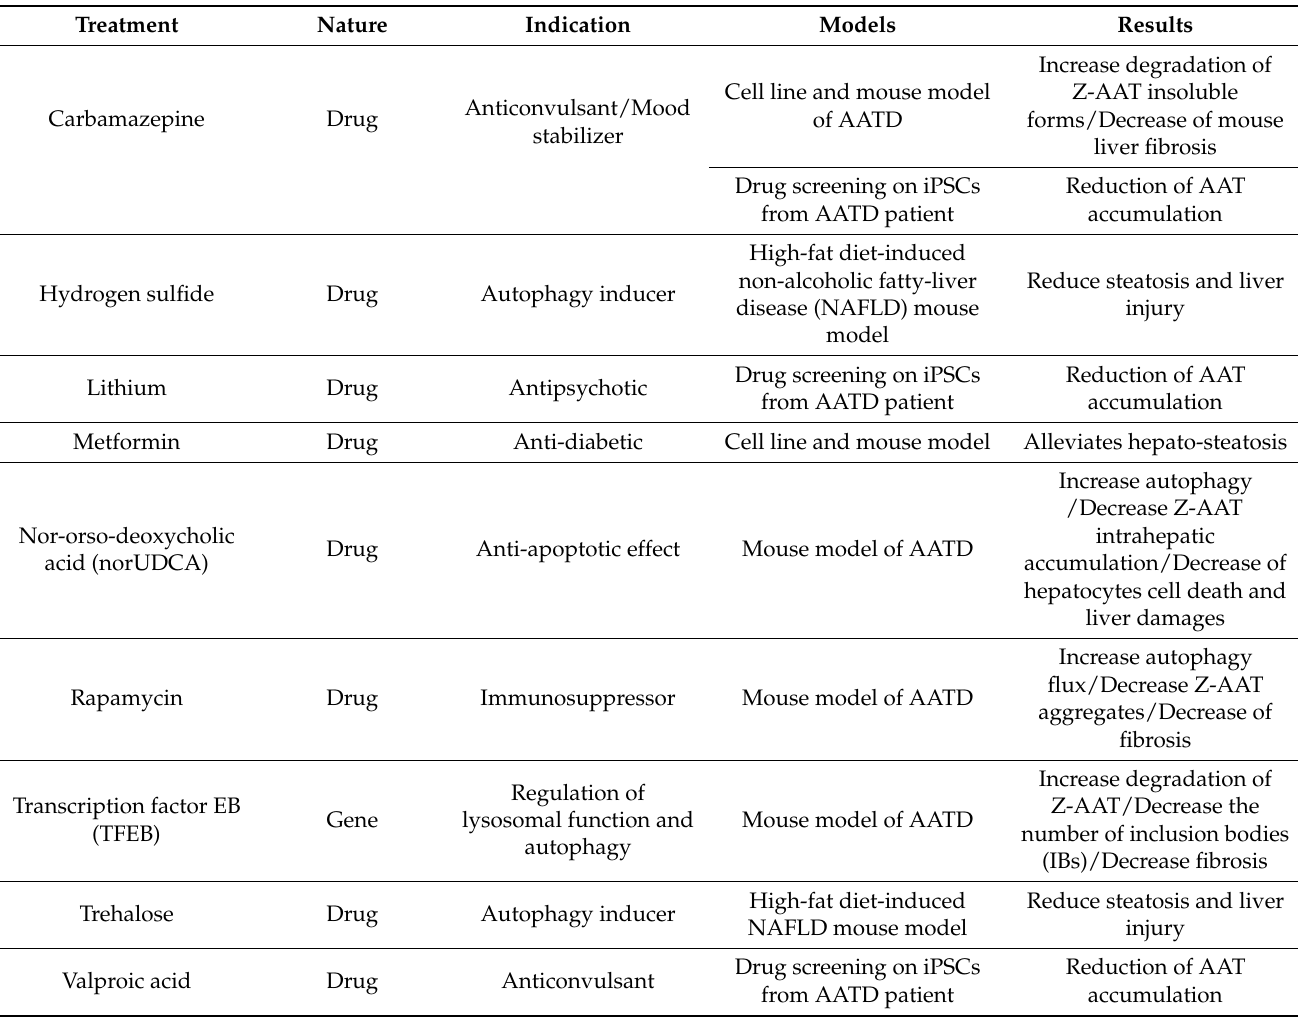
Table 1. Autophagy enhancer candidates for the treatment of alpha 1-antitrypsin deficiency- (AATD)-associated liver